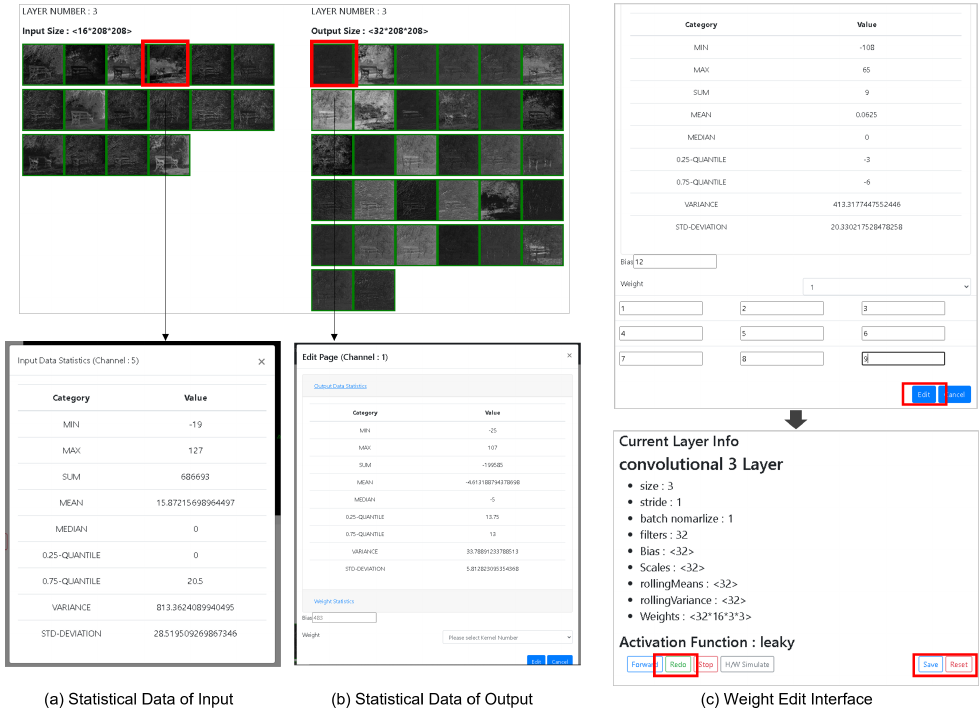
Figure 9. The results of performing inference of specific layer of selected neural network